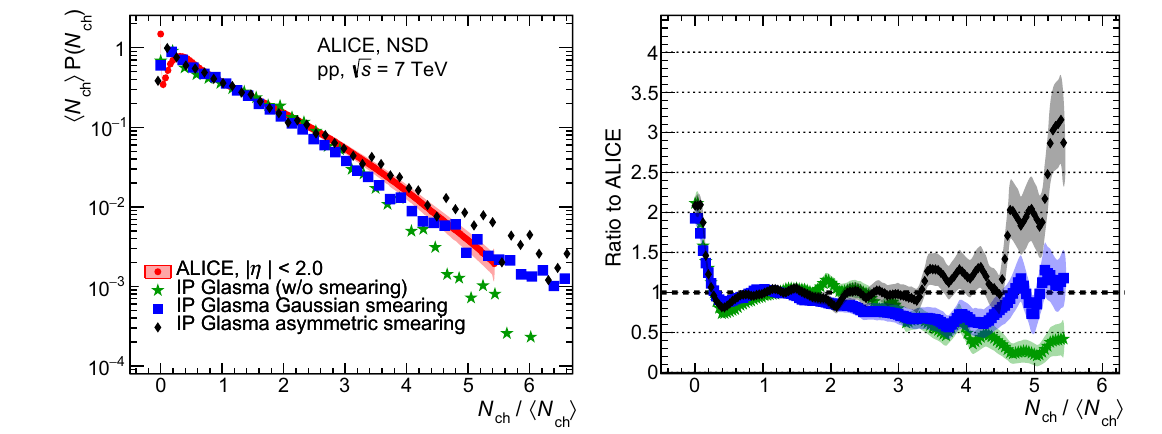
Fig. 8 Charged-particle multiplicity distributions for pp collisions at √ s = 7 TeV compared to distributions from the IP-Glasma model with the ratio between Q s and the color charge density either fixed (green